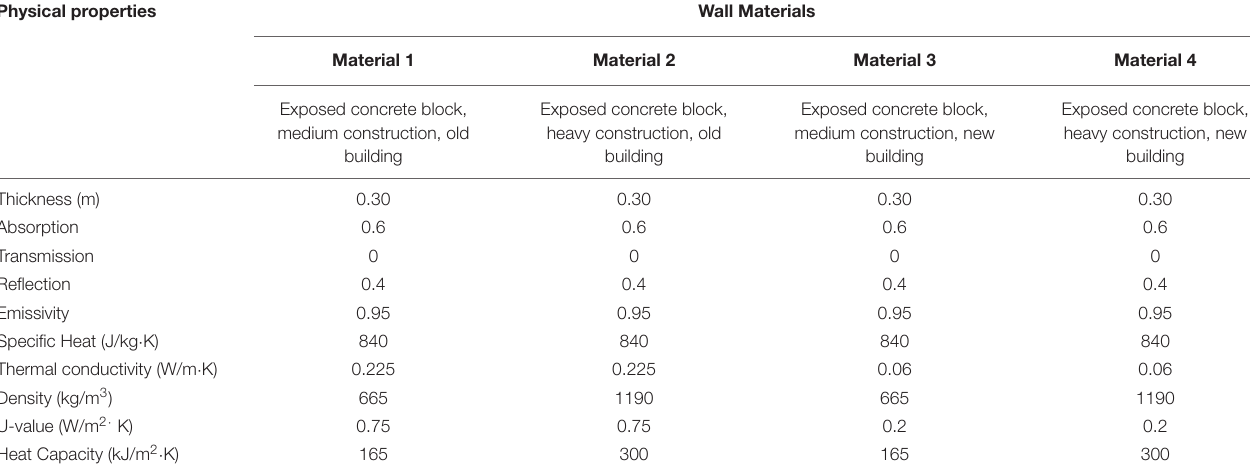
TABLE 4 | Physical properties of the wall materials used in the ENVI-met model.